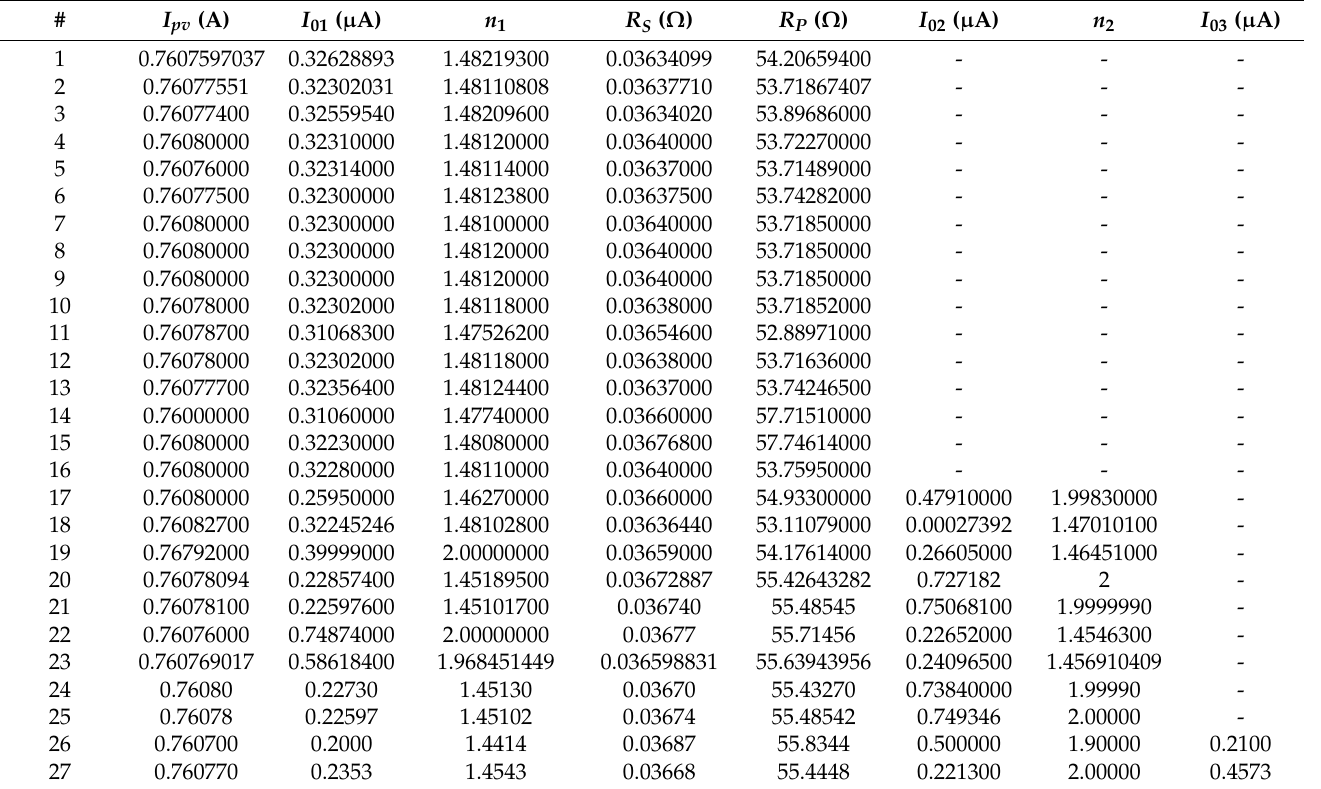
Table 2. Parameters of the equivalent circuit models of the solar RTC France cell using the methods presented in Table